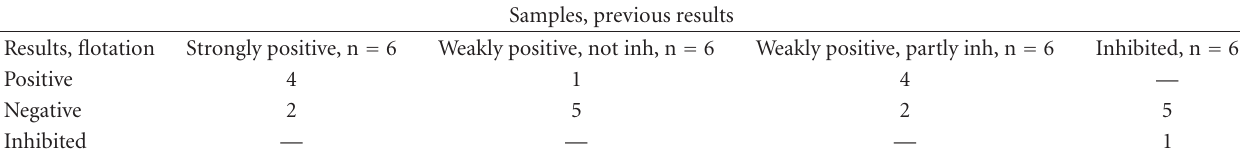
Table 2: The results from PCR analyses of 24 selected samples prepared by an optimized small-scale flotation setup. Aliquots of the samples had previously been judged as strongly positive a , weakly positive b , partly inhibited c (inh), or inhibited d by boiling lysate combined with nested PCR.